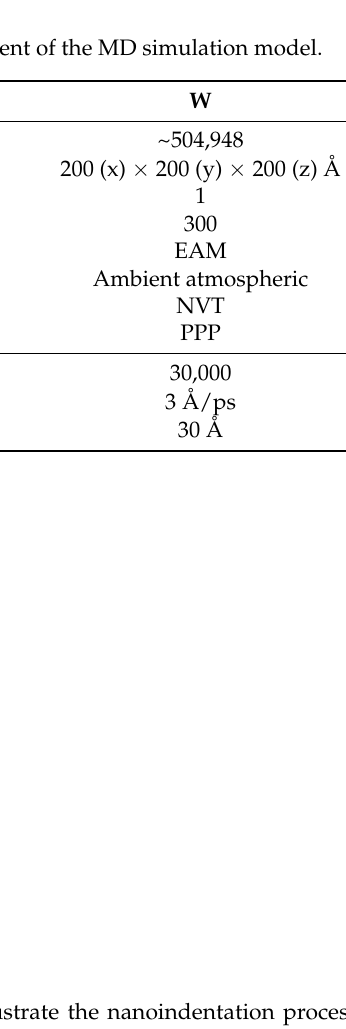
Table 1. Computational details used for the development of the MD simulation model.